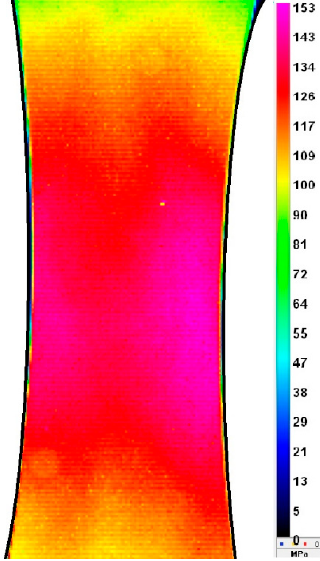
Figure 6. Bulk stress field in the coating at 2,293,500 cycles.